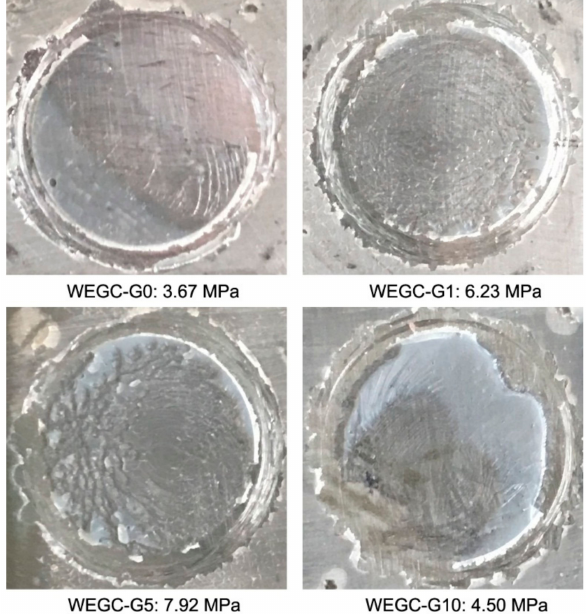
Figure 10. Pull-o ff test results for the WEGC applied on a steel